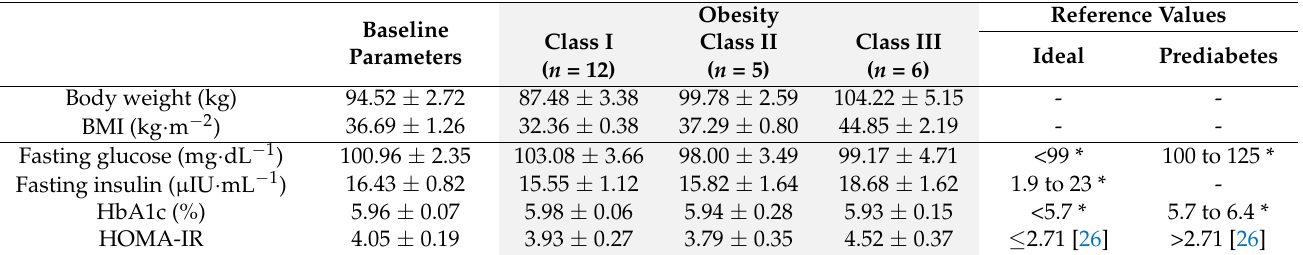
Table 1. Baseline parameters of participants ( n =